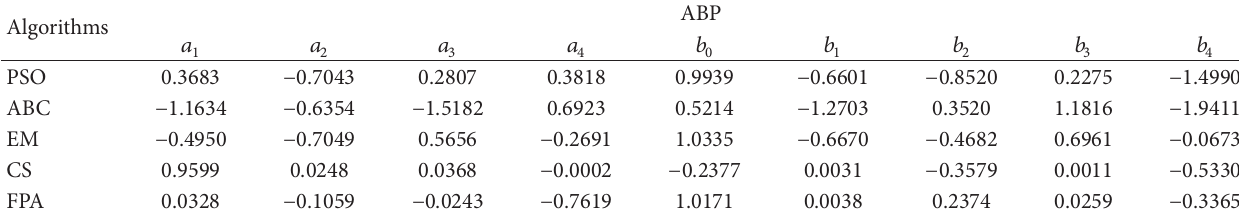
Table 3: The best parameter values (ABP) for the second experiment.